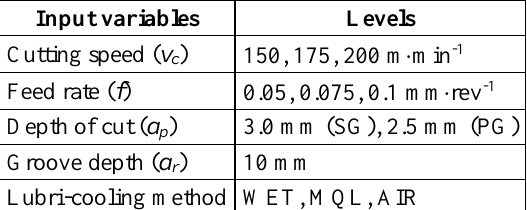
Table 1: Machining parameters and conditions.